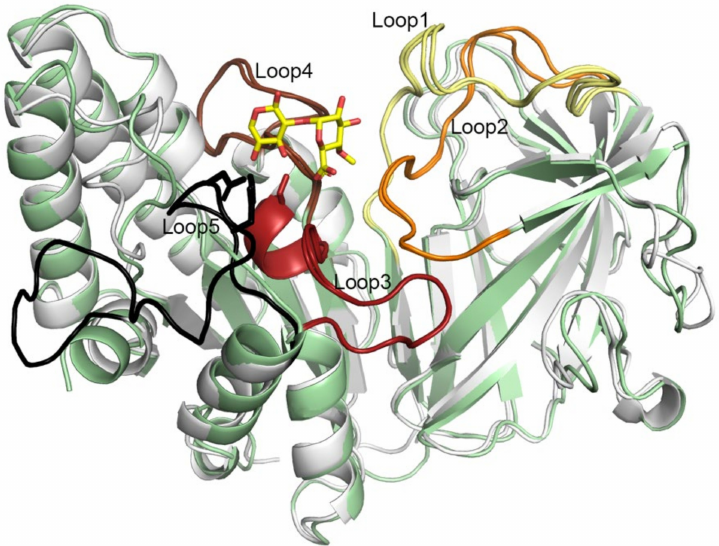
Figure 7. Overlaid crystal structures of acetyl xylan esterases from Prolixibacter bellariivorans , (gray) in complex with MeGlc p A-(1 → 2)-Xyl p ligand (yellow) and Chryseobacterium sp. YR480 (light green). The five conserved loops in the AcXEs are shown in yellow, orange, red, brown and black. The catalytic serine is shown in